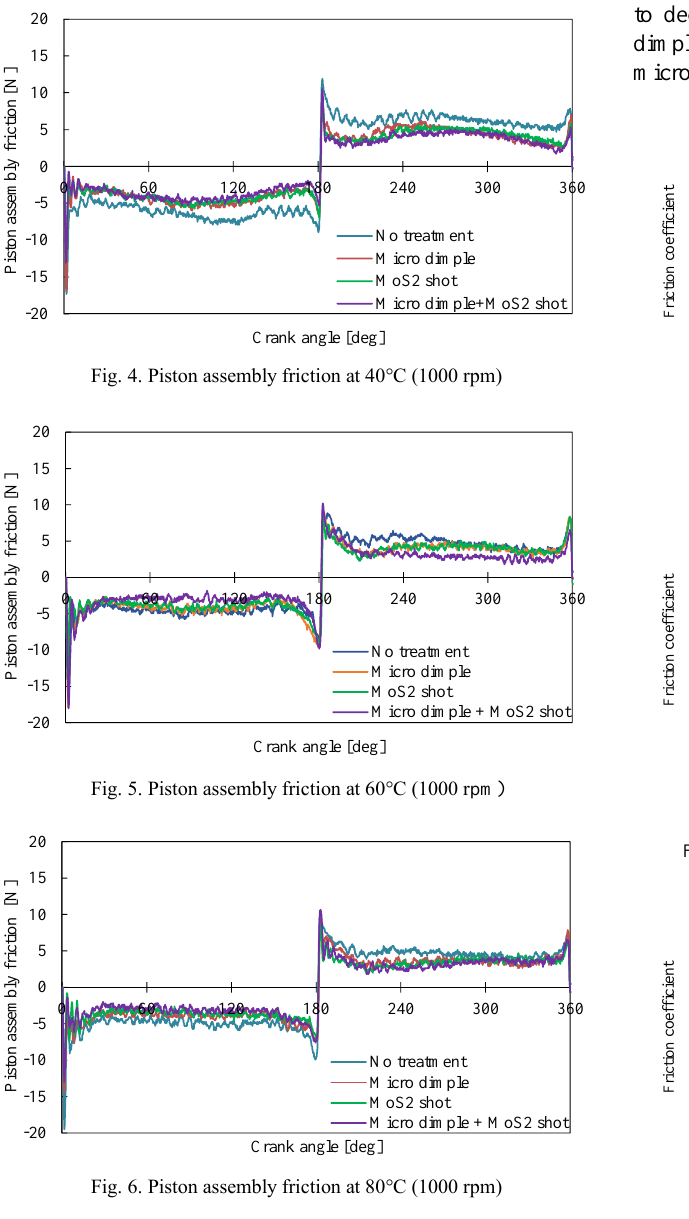
Fig. 9. Stribeck diagram in MoS 2 shot treatment (1000